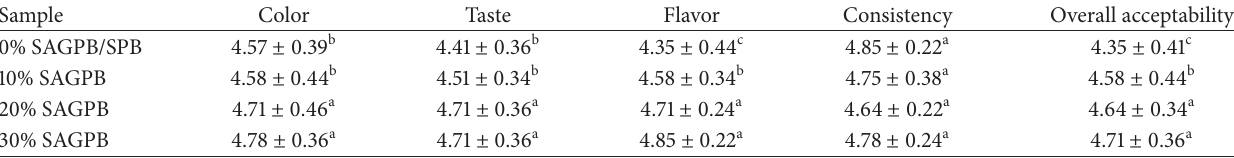
Table 1: Sensory acceptability of spiced papaya—Aloe gel beverage (SAGPB) blends.